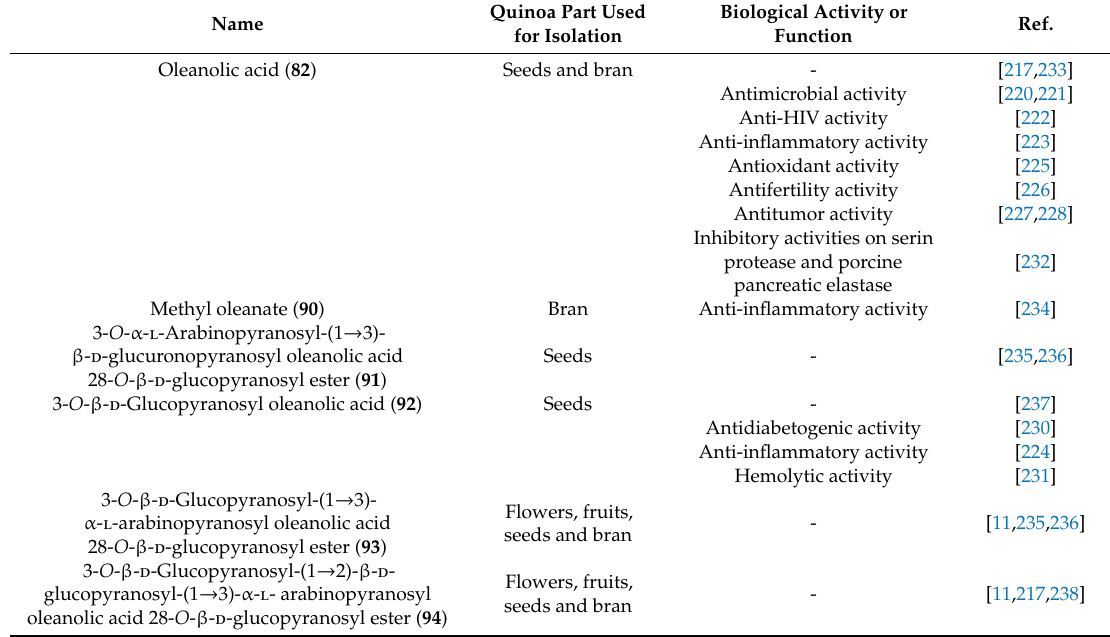
Table 9. Oleanolic acid derivatives and their biological activities or